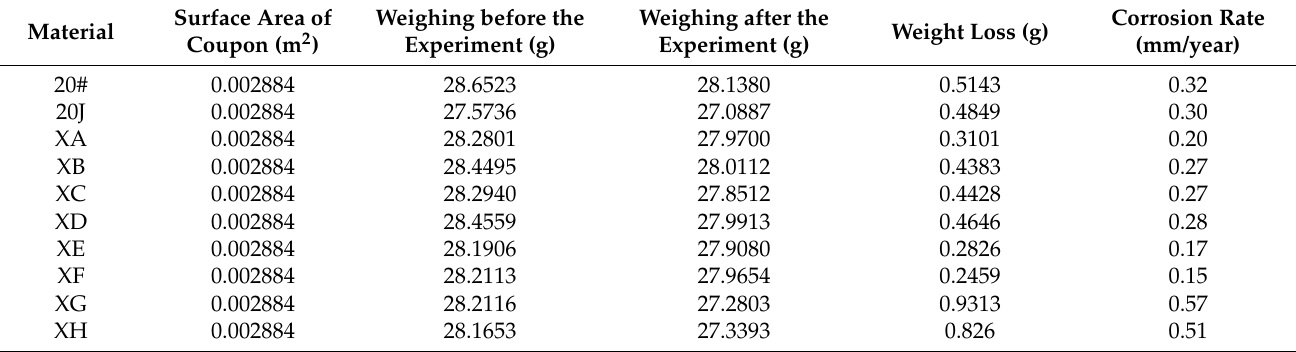
Table A2. Corrosion rate in the case of pH value of 2.5.